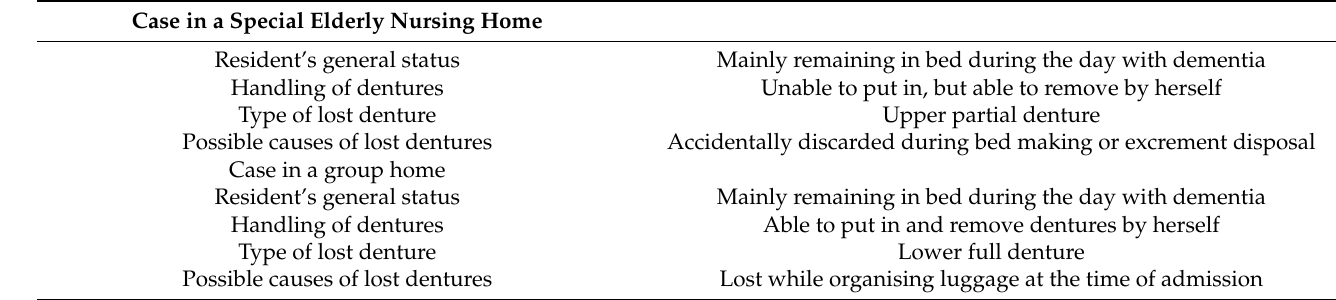
Table 2. Summary of the cases of denture